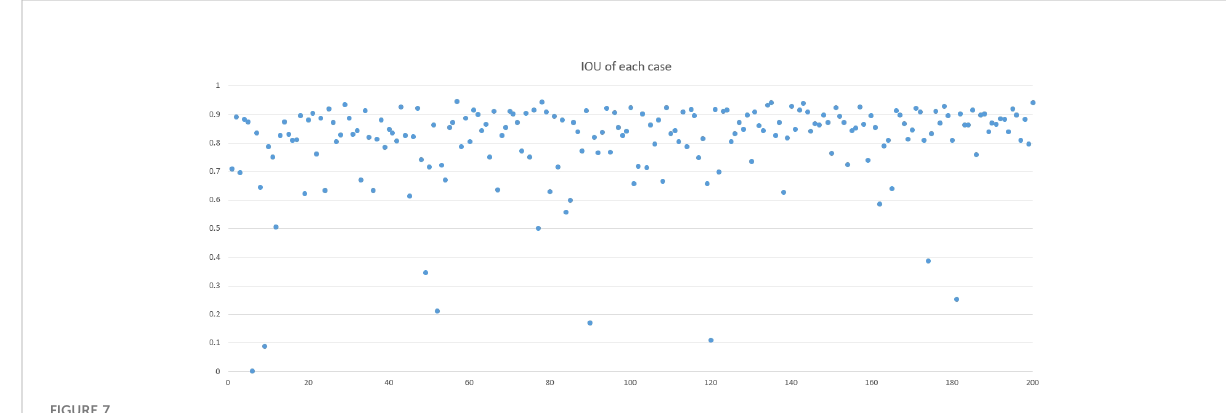
FIGURE 7 Dice similarity coef fi cient and intersection over union performance.